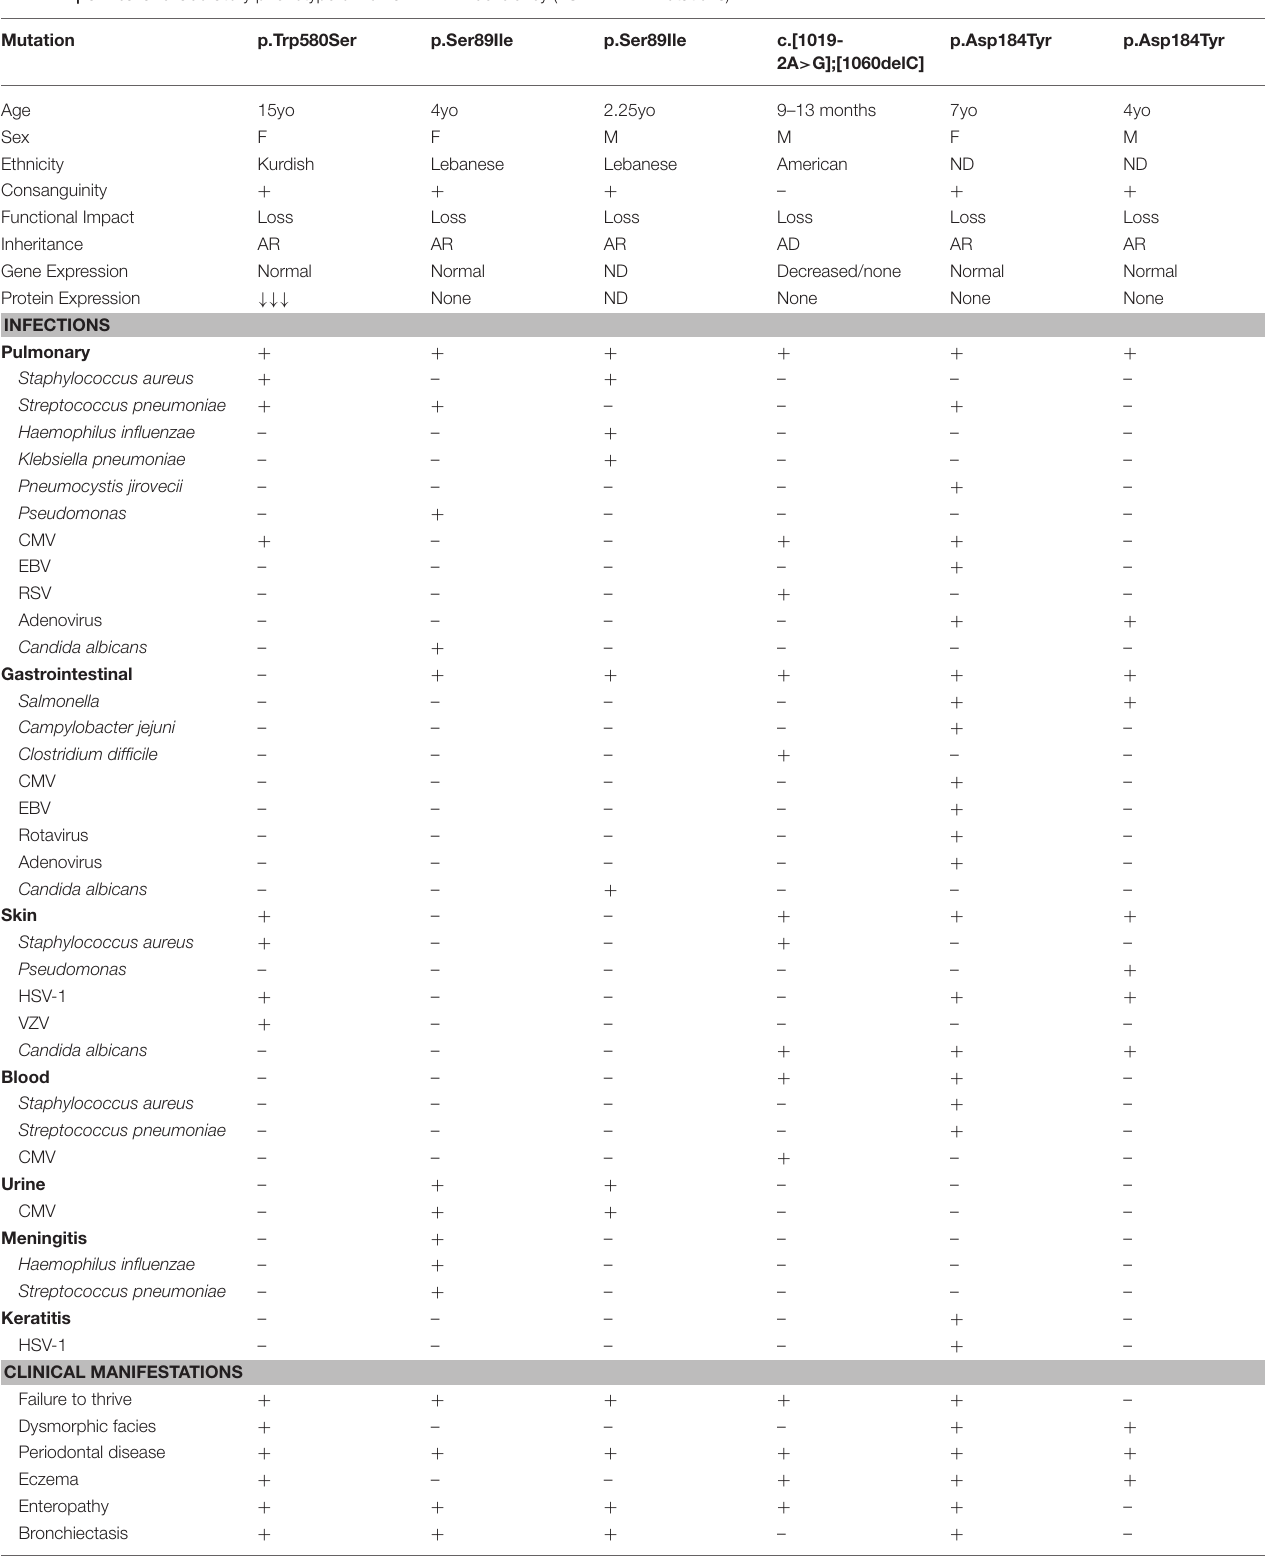
TABLE 7 | Clinical and laboratory phenotype of human MALT1 deficiency (LOF MALT1